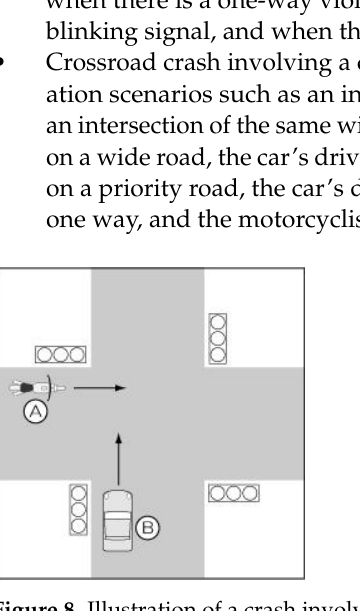
Figure 8. Illustration of a crash involving a car and a motorcycle at an intersection with traffic lights. From https://jiko-online.com/wp/kasitu/jiba-tyoku/ (accessed on 8 September